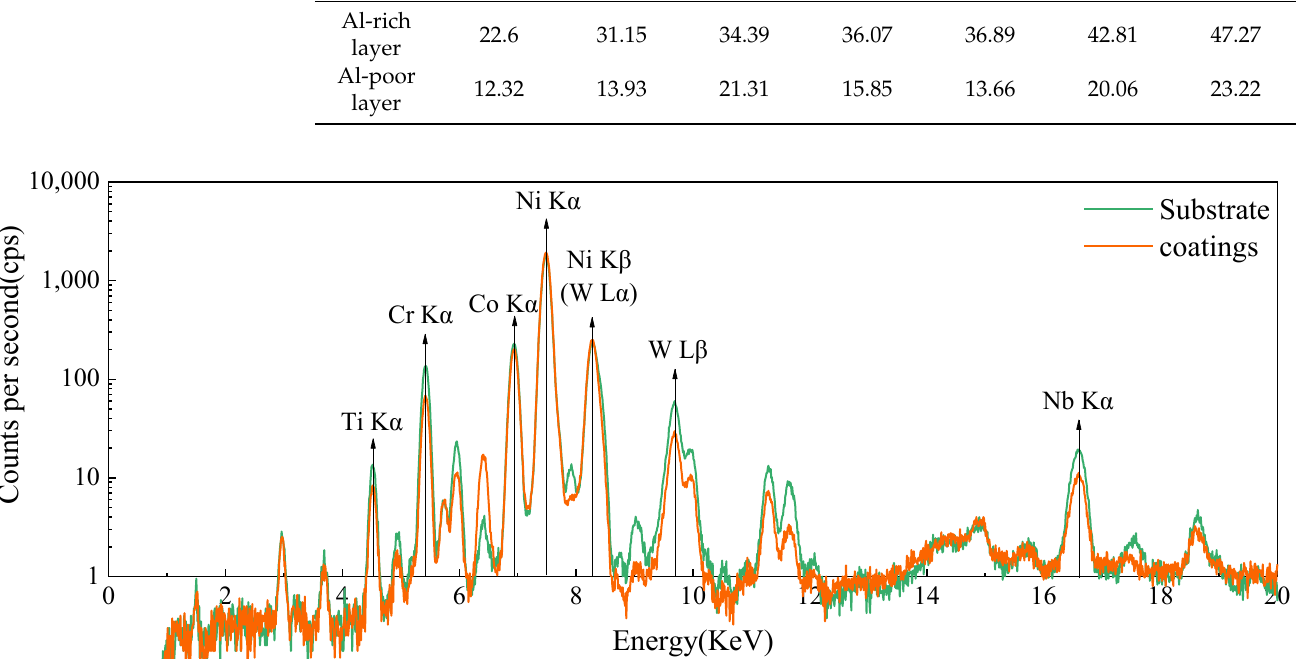
Table 4. Coating thickness calibration value ( µ m).